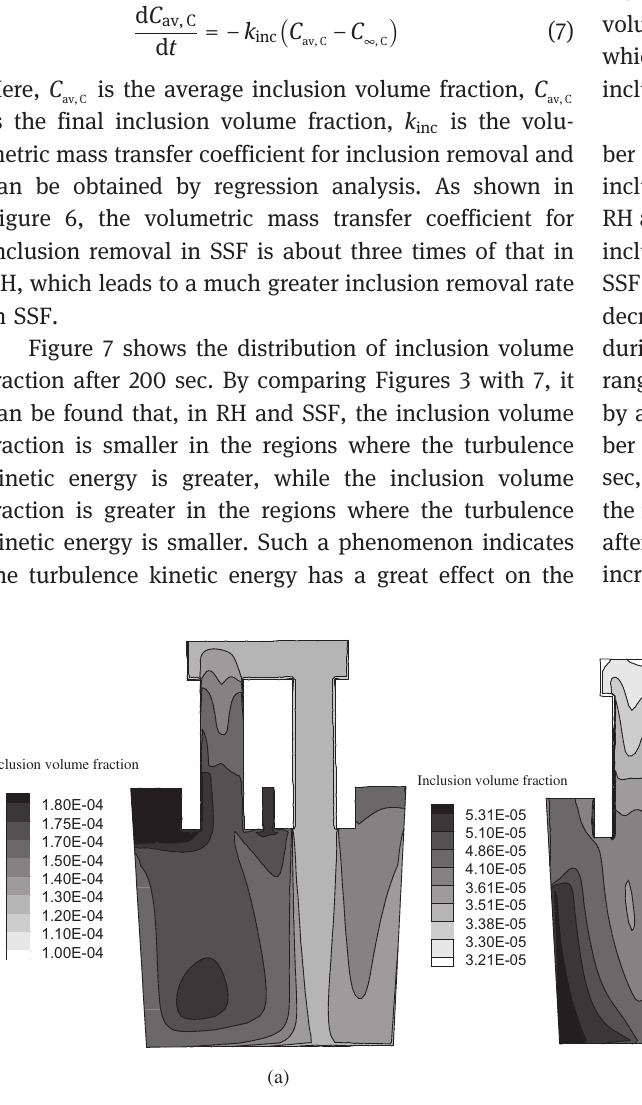
Figure 7: Distribution of inclusion volume fraction at the main plane after 200 sec. (a) RH (b)